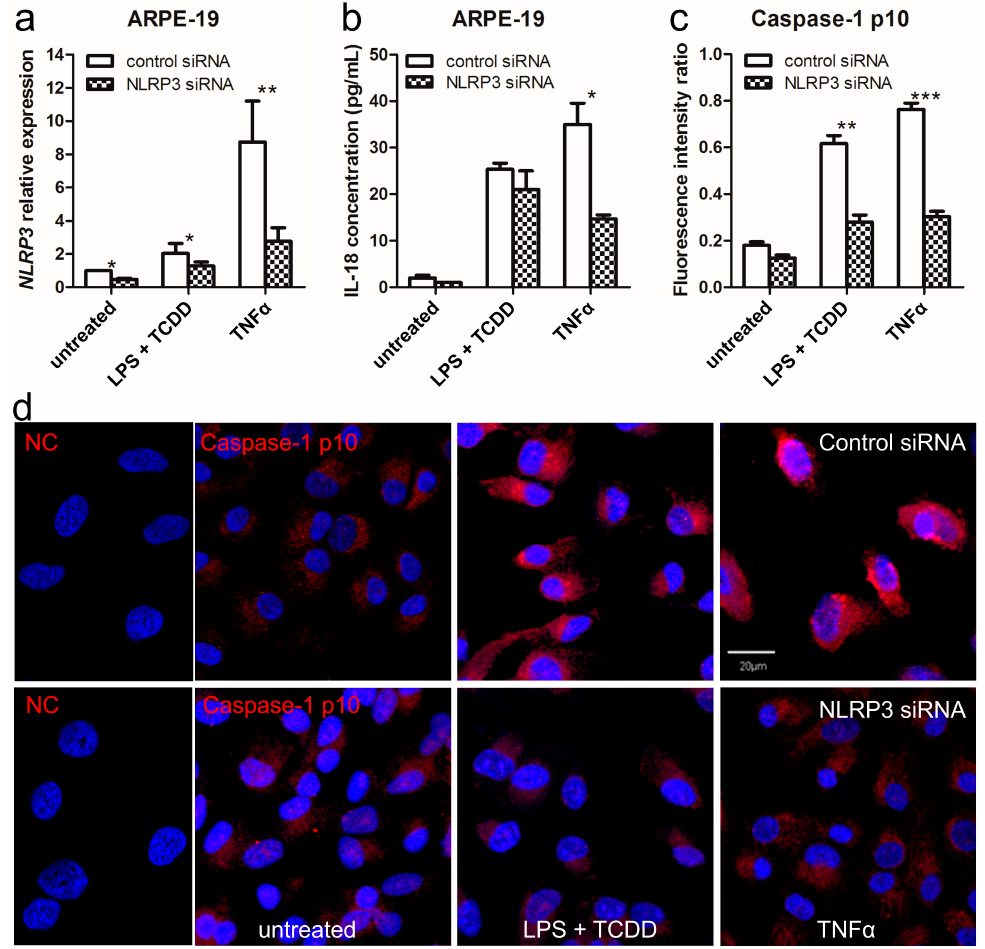
Figure 3. NLRP3 knockdown inhibits inflammasome activation in human ARPE-19 cells under inflammation and oxidative stress. ( a ) qRT-PCR analysis of NLRP3 mRNA shows significantly lower in ARPE-19 cells stimulated with LPS + TCDD and TNF α for 24 h after siRNA transfection ( n = 4); ( b ) ELISA analysis of IL-18 in the supernatants of ARPE-19 cells treated with LPS + TCDD and TNF α shows a significant decrease after siRNA transfection ( n = 4); ( c ) The caspase-1 p10 protein ratio of immunohistochemistry is calculated. Image-J software is used to measure the band intensity in pixels ( n = 4) and demonstrate significantly reduction in the siRNA transfected ARPE-19 cells; ( d ) Confocal microscopy of ARPE-19 treated with LPS + TCDD and TNF α for 24 h illustrates lower intensity (faint red color) after siRNA transfection ( n = 4). Normal IgG was used as primary antibody in the negative control (NC). Caspase-1 p10 subunit was labeled in red . The nuclei were stained with DAPI ( blue ). Data are presented as mean ± SEM. * p < 0.05; ** p < 0.01; *** p < 0.001. Scale bar = 20 µm.